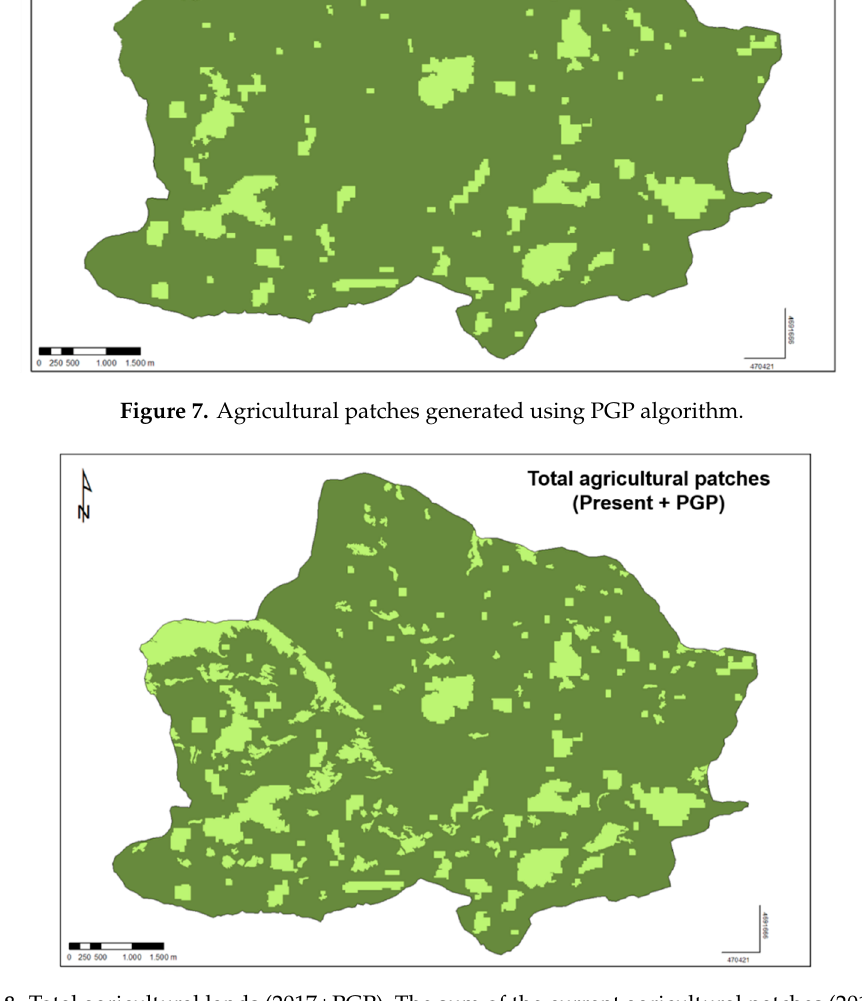
Figure 8. Total agricultural lands (2017+PGP). The sum of the current agricultural patches (2017) and agricultural patches created by PGP algorithm.